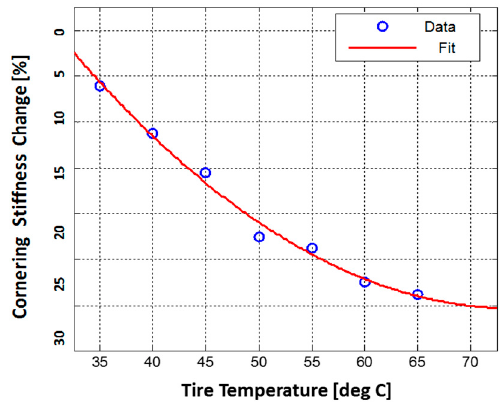
Figure 19. Model fitting results—temperature dependency.